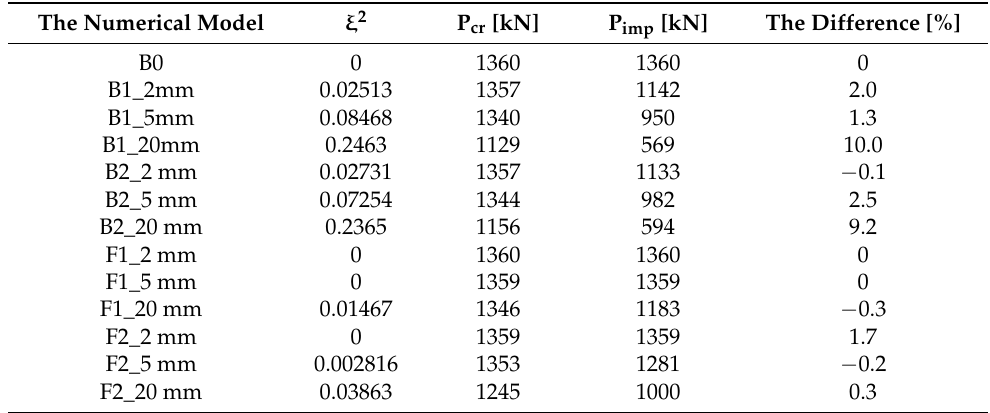
Table 2. Arbelo method